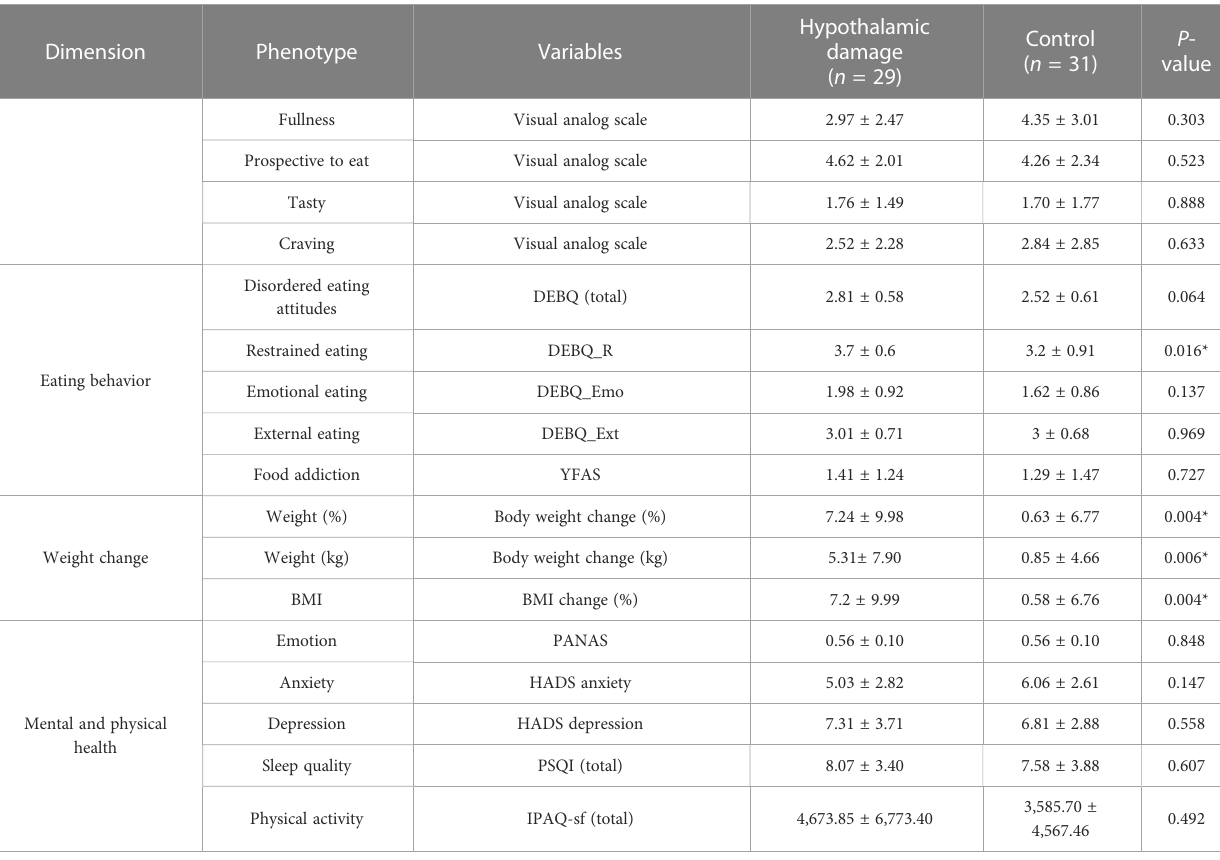
Figure 5A) fusiform gyrus. Additionally, a higher disordered eating attitude was signi fi cantly associated with lower activation of the right orbitofrontal cortex (OFC) ( r = − 0.429, P = 0.029, Figure 5B). Right OFC activation was signi fi cantly related to the inhibitory control (commission error rate) ( r = 0.439, P = 0.028, Figure 5B). Left hippocampus activation was signi fi cantly associated with both attention bias score ( r = 0.598, P = 0.0001, Figure 5C) and attention orienting score ( r = 0.446, P = 0.022, Figure 5C). Moreover, left hippocampus activation was negatively correlated with weight percent change ( r = − 0.452, P = 0.02, Figure 5C). Left amygdala activation was signi fi cantly associated with attention orienting score ( r = 0.410, P = 0.038, Figure